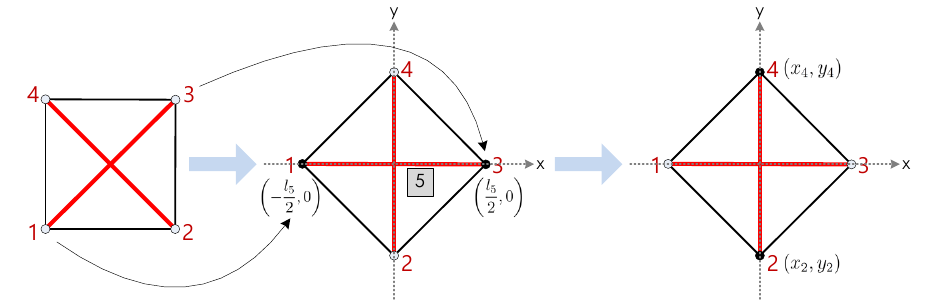
Figure 9. Designation process of the nodal coordinates of the 2D two-strut tensegrity structure.